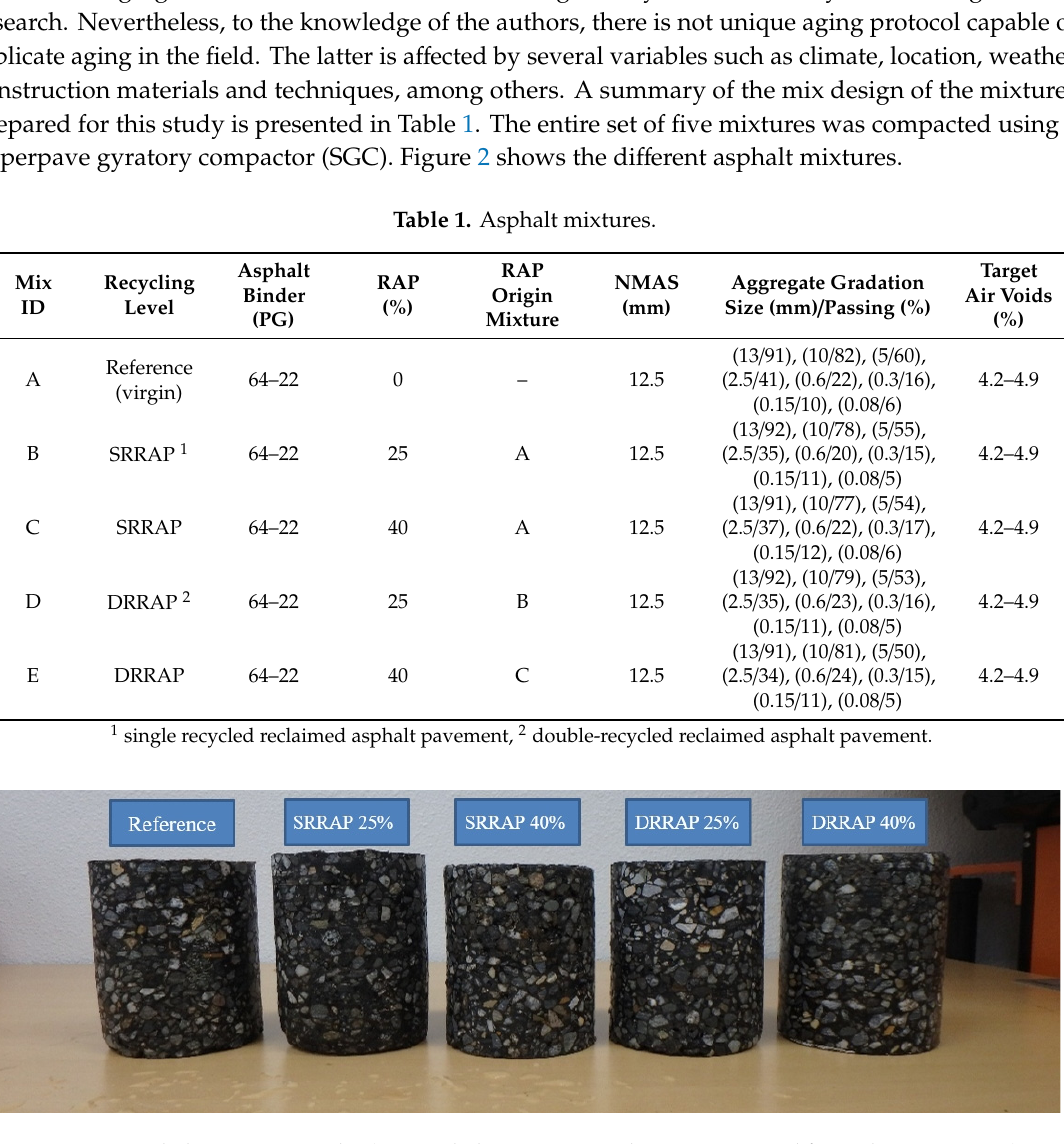
Figure 2. Asphalt mixture samples (two asphalt mixture samples were prepared for each mixture type).